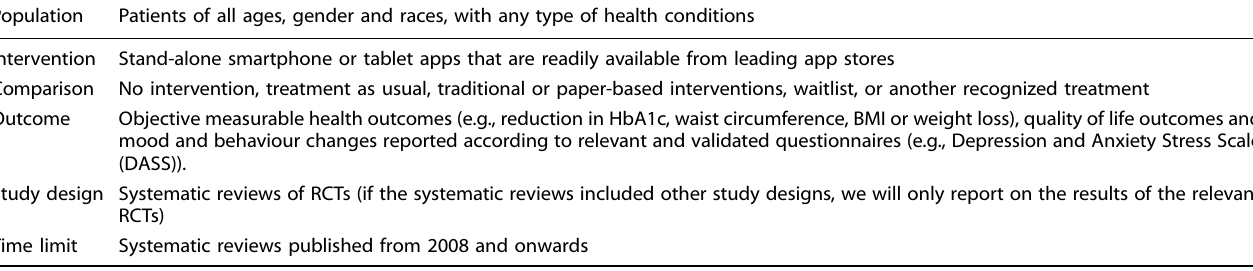
Table 4. Summary of inclusion criteria Population Patients of all ages, gender and races, with any type of health conditions Intervention Stand-alone smartphone or tablet apps that are readily available from leading app stores Comparison No intervention, treatment as usual, traditional or paper-based interventions, waitlist, or another recognized treatment Outcome